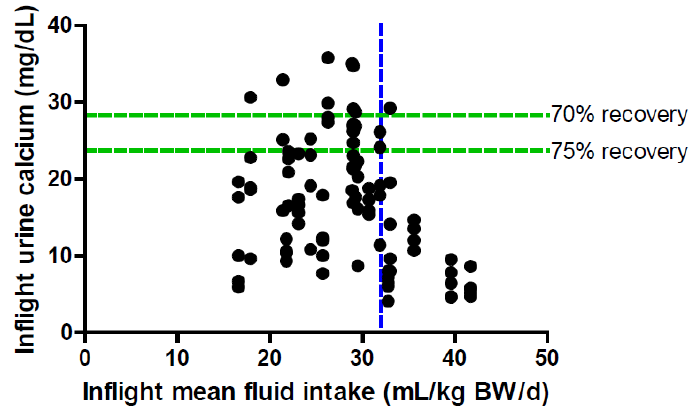
Figure 5. In-flight fluid intake and associated in-flight urinary calcium concentration of crewmembers on the ISS. Each symbol represents a 24-h urine collection; individual crewmembers may have provided up to five 24-h collections during flight, and at least 4 before flight. Dashed horizontal lines reflect urinary calcium concentrations above which calcium precipitation would be expected for UPA water recoveries at 70% and